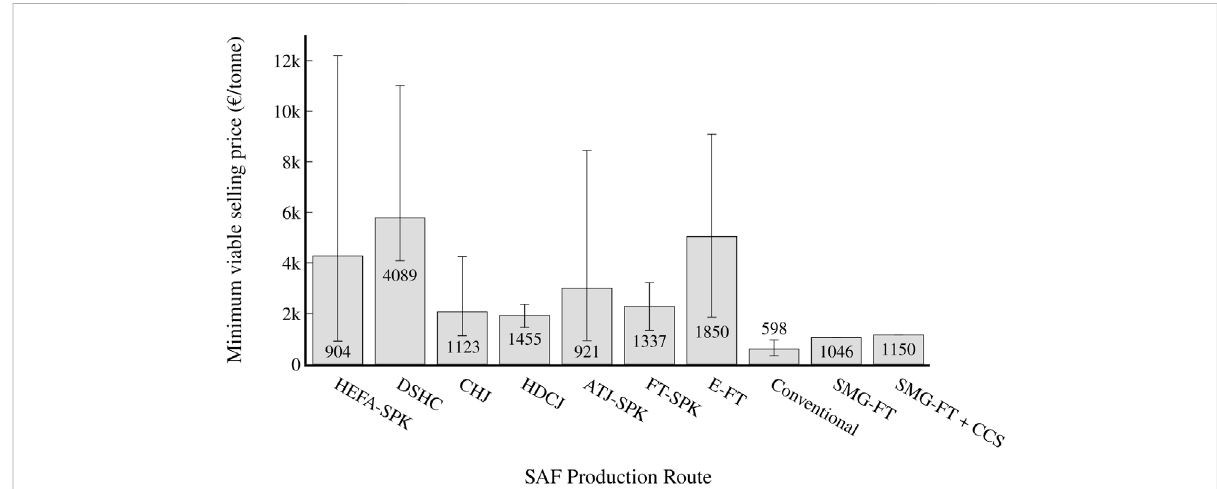
FIGURE 7 MVSP (production cost) of the various SAF benchmarks (see Benchmark de fi nition) and conventional aviation fuel. The grey bar represents the median cost found for each process route among studies, while the error bars correspond to the lowest and highest cost found for each process route. The text states the lowest found cost for each production